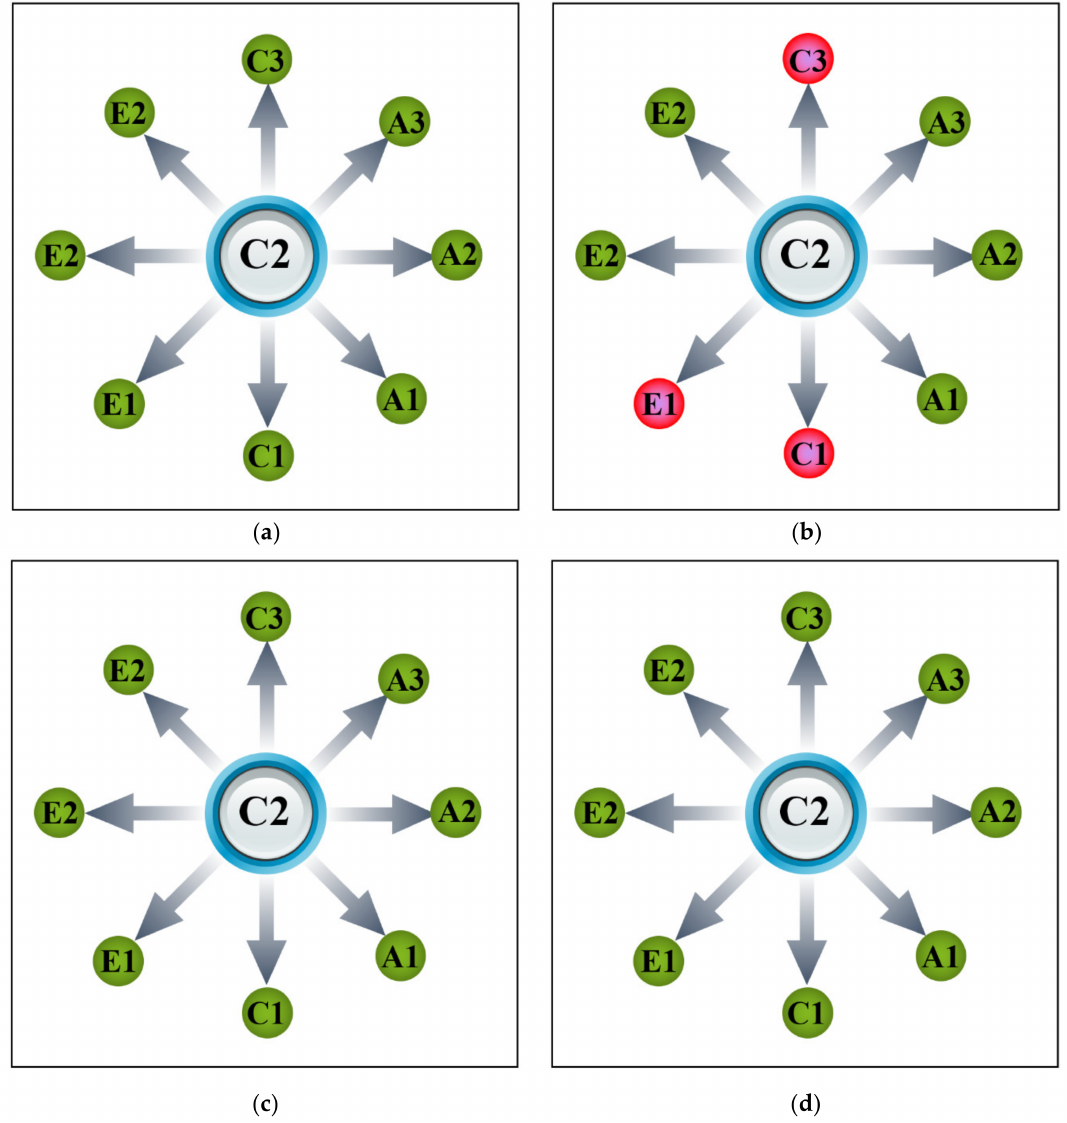
Figure 4. Tukey pairwise comparison between the control sensor and other sensors for T ( a ), RH ( b ), T dp ( c ), and VPD ( d ) in